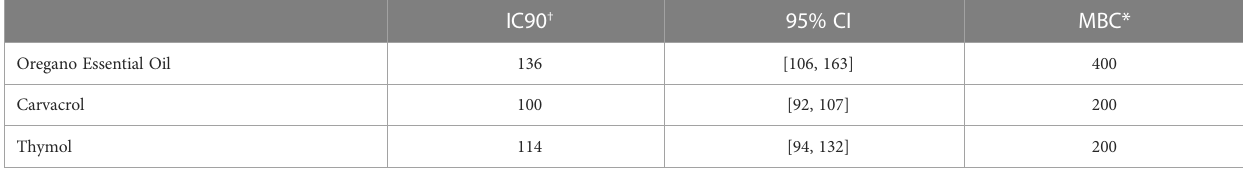
TABLE 1 Inhibitory concentrations of oregano essential oil, carvacrol and thymol against Xanthomonas citri subsp. citri